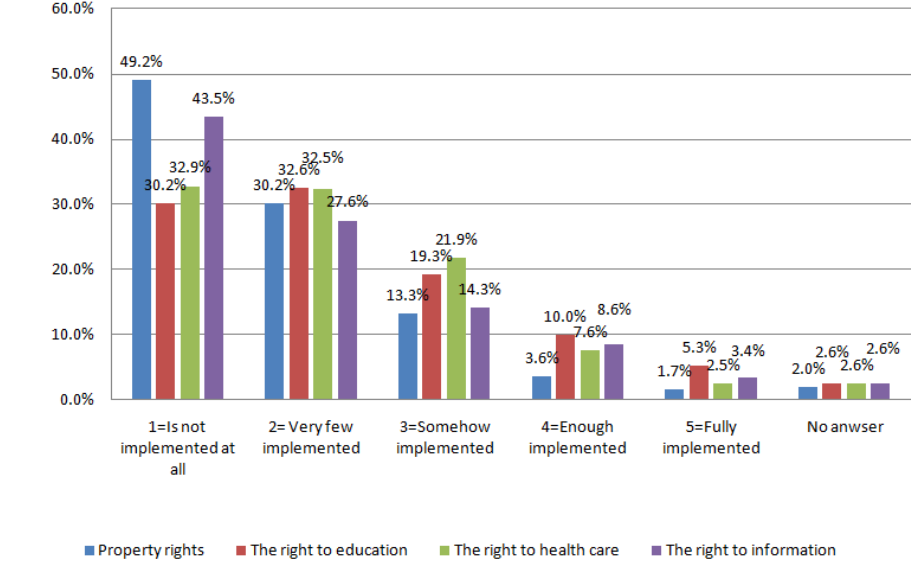
Figure 3: The Perceptions About the Implementation of the Civil Rights (Offline Sample) (Zotaj and Madhi 2019,